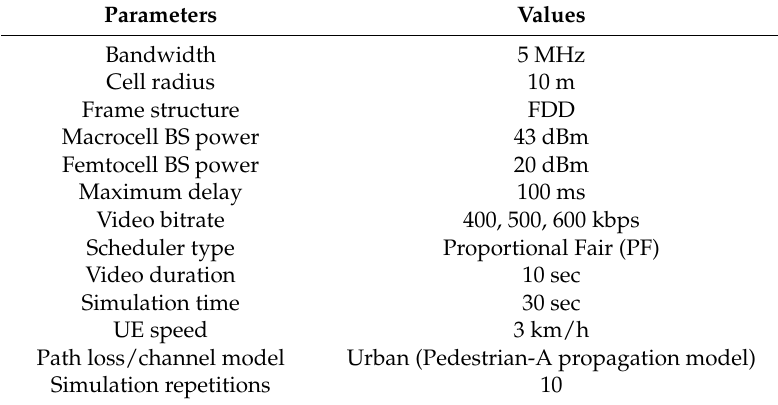
Table 2. Downlink small cell (i.e., femtocell) simulation